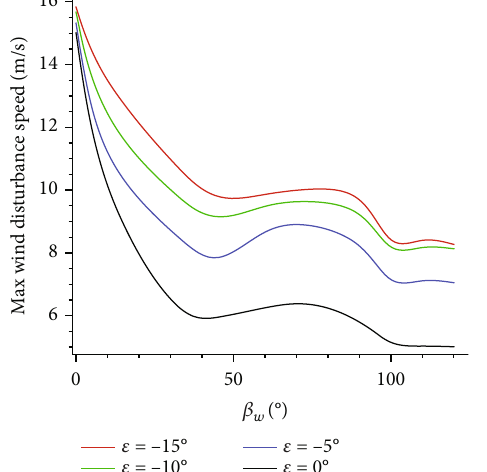
Figure 42: Wind disturbance rejection performance with di ff erent rotor incline angles.